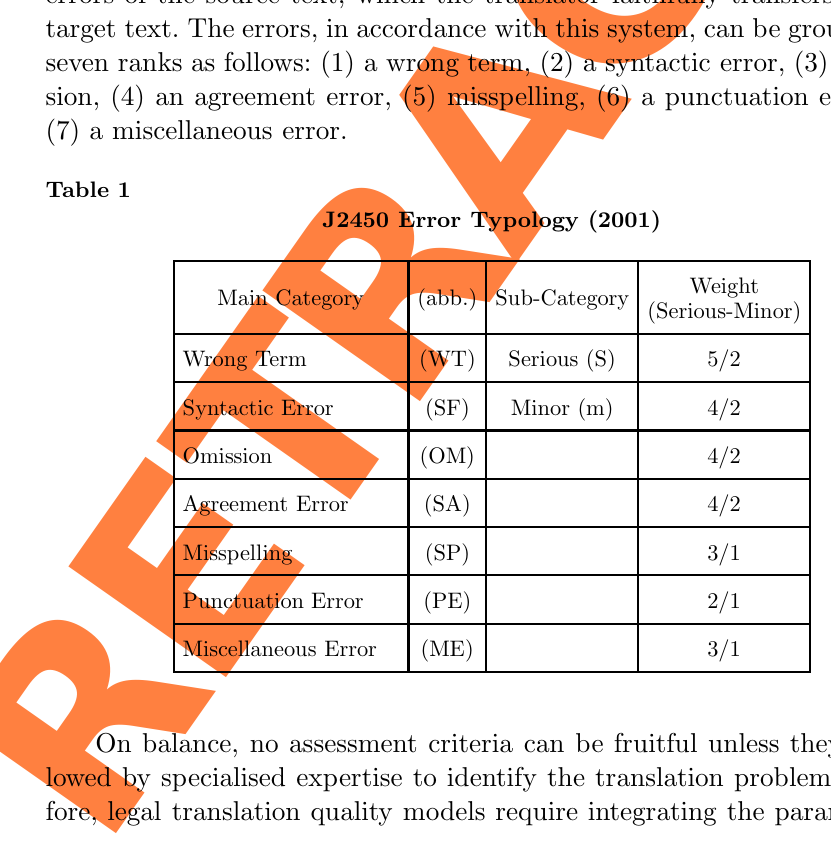
J2450 Error Typology (2001) Main Category (abb.) Sub-Category